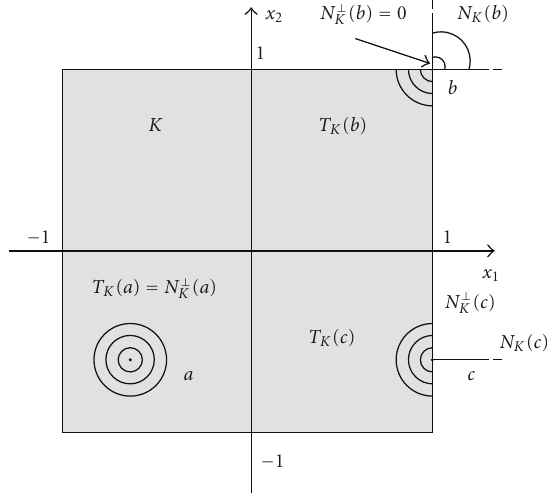
Figure 1: Set K = [ − 1,1] 2 and cones T K , N K , and N ⊥ at points a , b , K and c of K (the cones are shown translated into the corresponding points of K ). Point a belongs to the interior of K , and hence T K ( a ) is the whole space R 2 , while N Q ( a ) reduces to { 0 } . Point b coincides with a vertex of K , and so T K ( b ) corresponds to the third quadrant of R 2 , while N K ( b ) corresponds to the first quadrant of R 2 . Finally, point c belongs to the right edge of the square and, consequently, T K ( c ) coincides to the left half plane of R 2 , while N K ( c ) coincides with the nonnegative part of x 1